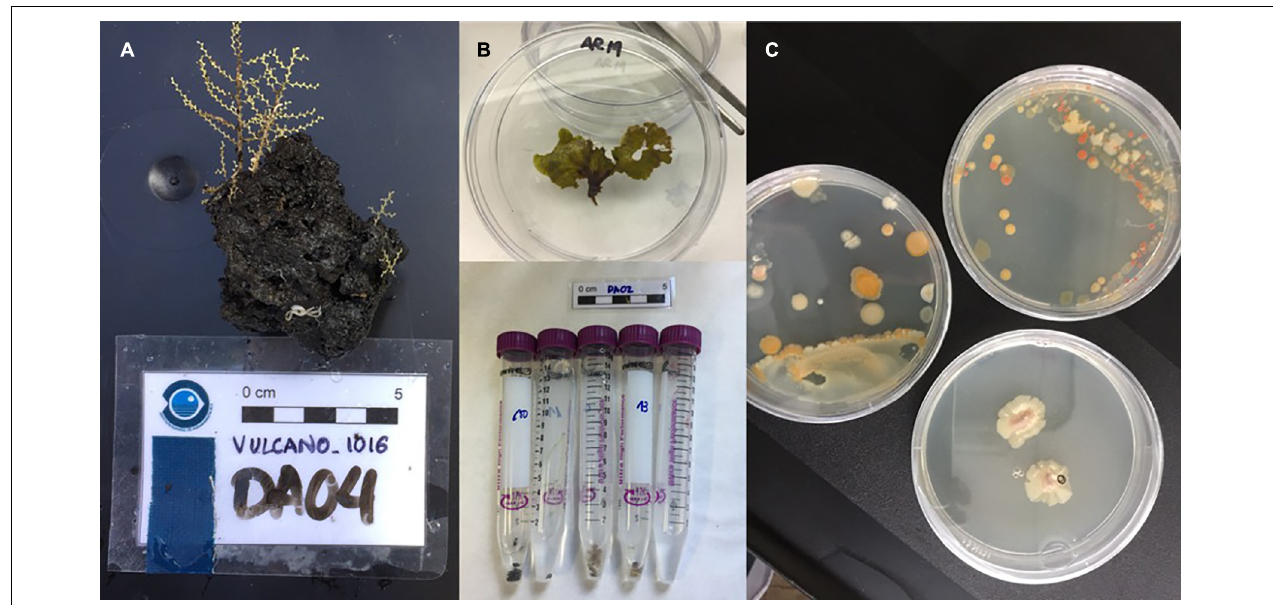
FIGURE 2 | (A) Hydrozoan Sertularella sp. (Depht: –170 to 270 m) from DA04. (B) Environmental samples AR19 and AR10–AR14 in sterile containers. (C) Microbial diversity observed in processed